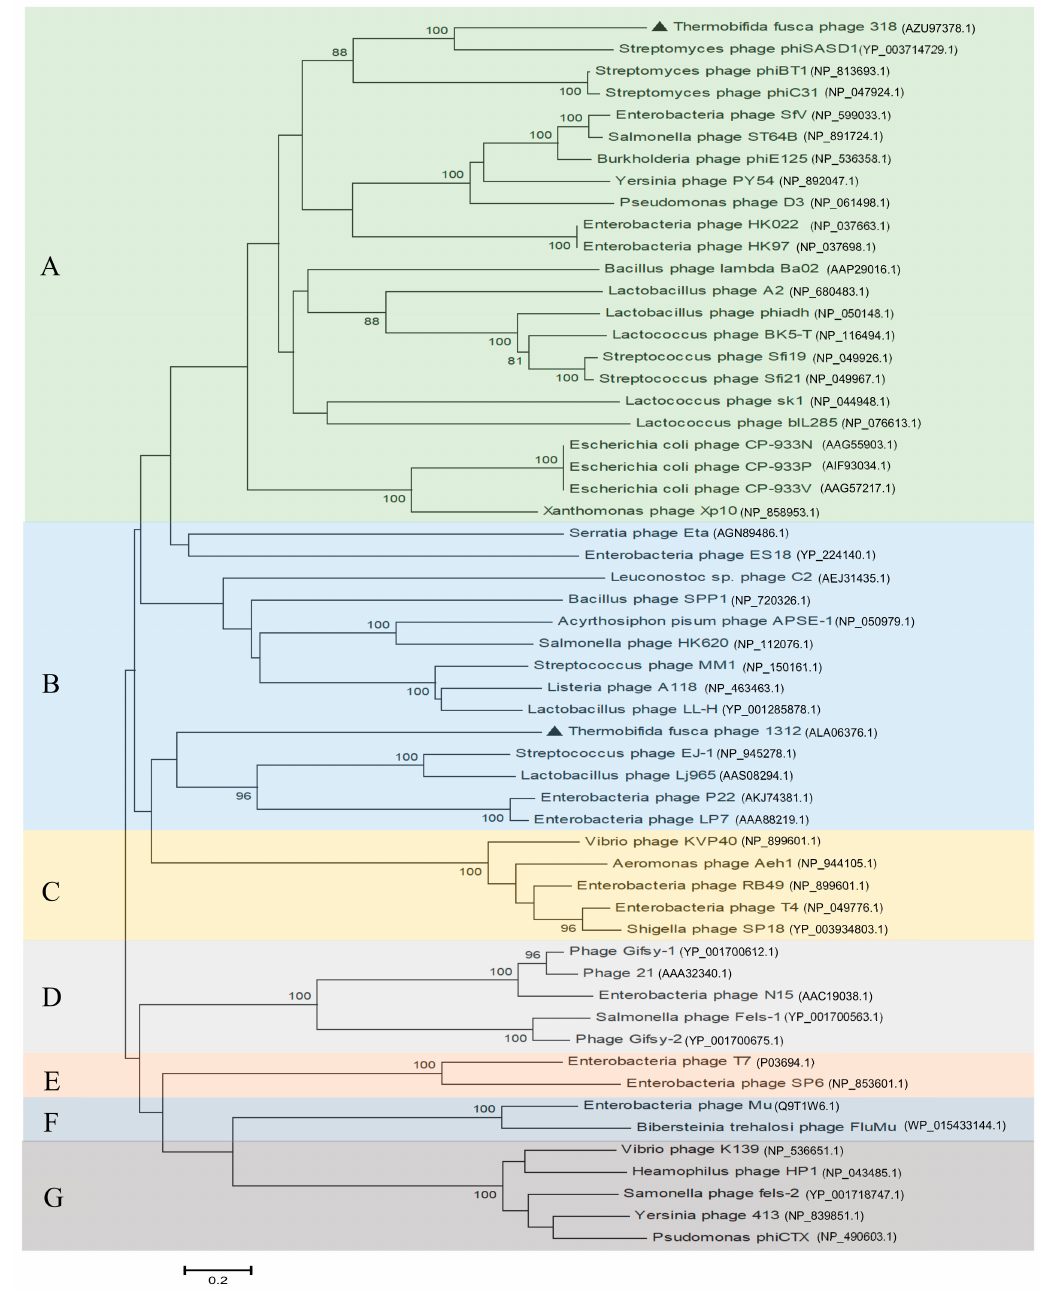
Figure 3. Phylogenetic analysis of the terminase large subunit of P318. The neighbor-joining phylogenetic tree shows the classification of the large terminase subunit of P318, P1312, and other phages with known packaging mechanisms. ( A ) 3 (cid:48) -extended COS ends; ( B ) P22-like headful; ( C ) T4-like headful; ( D ) λ like 5 (cid:48) -extended COS ends; ( E ) T7-like direct terminal repeats; ( F ) Mu-like headful; ( G ) P2-like 5 (cid:48) -extended COS ends. Bootstrap analysis of the phylogenetic tree was performed using 1000